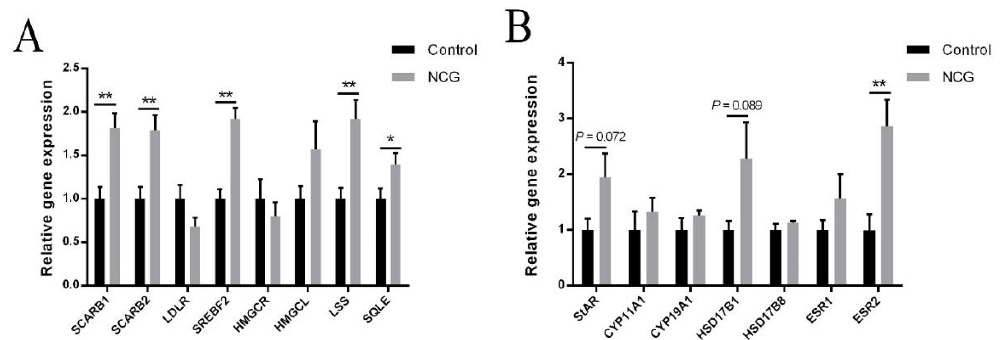
Figure 6. Effects of NCG on the relative expression profiles of genes related to cholesterol metabolism in yak ovaries. ( A ) Genes related to cholesterol biosynthesis. ( B ) Genes related to steroid hormone biosynthesis. Data are represented as mean ± SEM, n = 6. * p < 0.05, ** p < 0.05.